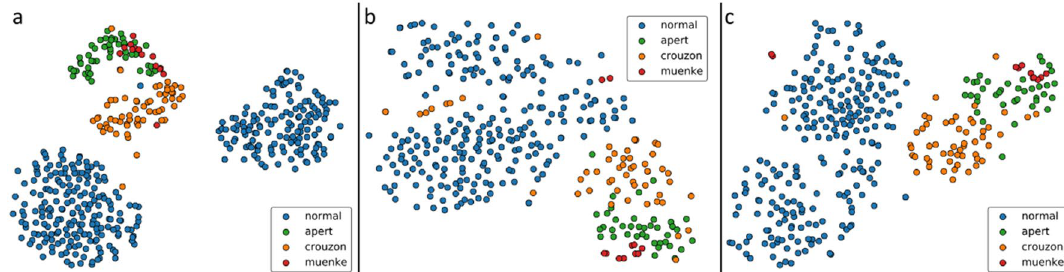
Figure 1. t-SNE embeddings of face-only ( a ), head-only ( b ), and combined head-and-face ( c ) models from left to right respectively. In all cases, distinct clusters emerge for healthy and syndromic samples. The clearest disambiguation between samples is observed for the face-only model.